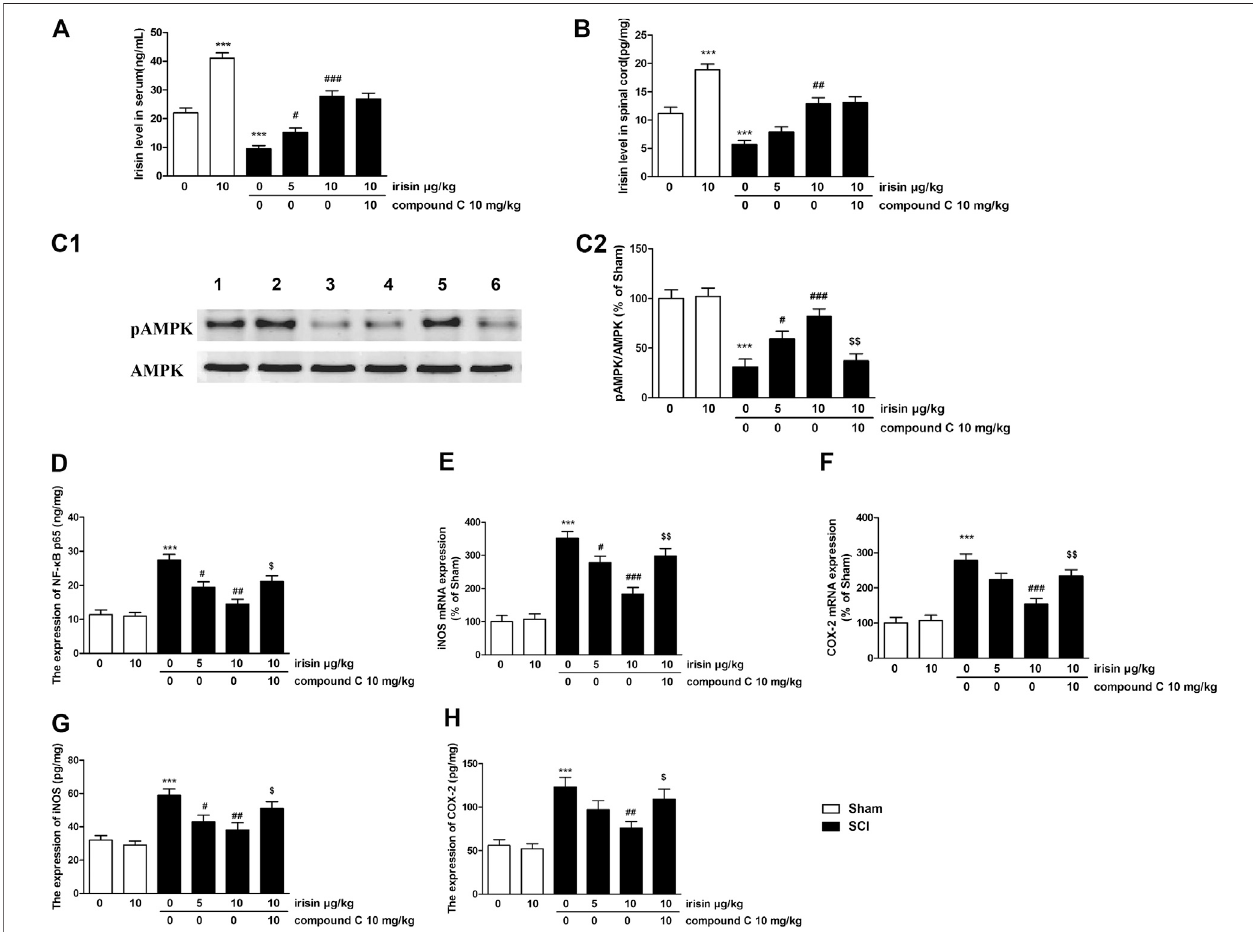
FIGURE 3 |(A) Expression ofirisin in the serum ofsham/spinal cord injury (SCI) rats (*** p (cid:2) 0.00011for SCI group, ### p (cid:2) 0.00008 for SCI + 10 μ g/kg irisin group). (B) Expression of irisin in the spinal cord of sham/SCI rats (*** p (cid:2) 0.00018 for SCI group, ### p (cid:2) 0.0017 for SCI + 10 μ g/kg irisin group). (C) Effects of irisin on pAMPK expression in the spinal cord in sham/SCI rats, and the quantitative analysis of the blots (*** p (cid:2) 0.00015, ### p (cid:2) 0.00078, $$ p (cid:2) 0.0014). blot 1: sham; 2: irisin-treated sham;3:SCI;4 – 5:irisin(5,10 μ g/kg,i.v)treatedSCI;6:compoundCtreatedgroup. (D) EffectsofirisinonNF- κ Bp65expressioninthespinalcordinsham/SCIrats (*** p (cid:2) 0.000027, ## p (cid:2) 0.0016, $ p (cid:2) 0.0134). (E,F) Effects of irisin on the mRNA expression of inducible nitricoxidesynthase (iNOS) (*** p (cid:2) 0.000012, ### p (cid:2) 0.00013, $$ p (cid:2) 0.0034) and COX-2 (*** p (cid:2) 0.000032, ### p (cid:2) 0.00047, $$ p (cid:2) 0.007) in the spinal cord of sham/SCI rats. (G,H) Effects of irisin on expressions of iNOS (*** p (cid:2) 0.00017, ## p (cid:2) 0.0051, $ p (cid:2) 0.047)andCyclooxygenase-2(*** p (cid:2) 0.00044, ## p (cid:2) 0.0058, $ p (cid:2) 0.038)inthespinalcordofsham/SCIrats.Dataarepresented asMean ± SEM, n (cid:2) 6. *** p < 0.001 when compared with sham group; # p < 0.05, ## p < 0.01 and ### p < 0.001 when compared with SCI model group; $ p < 0.05 and $$ p < 0.01 when compared with irisin-treated SCI group.